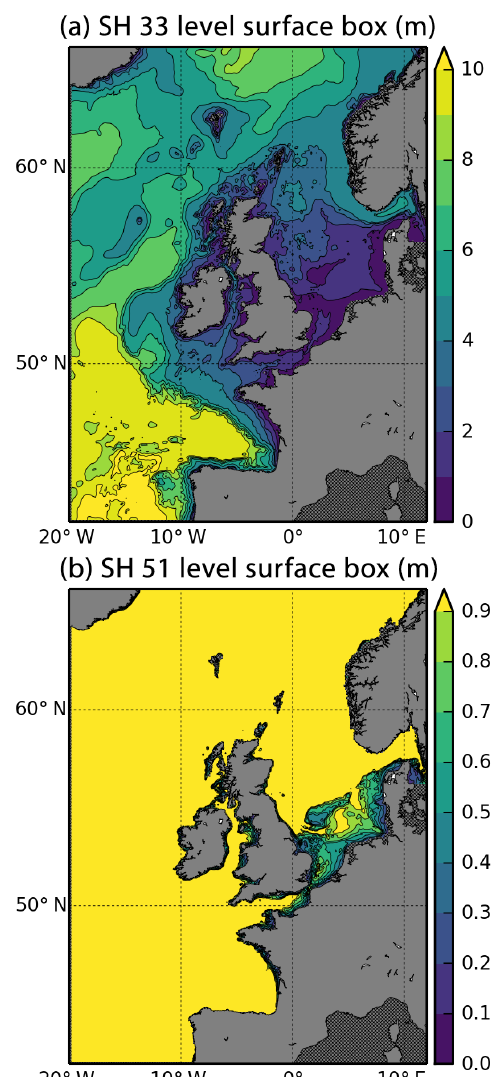
Figure 2. Thickness of surface model levels in CO4 (a) and CO5 (b)